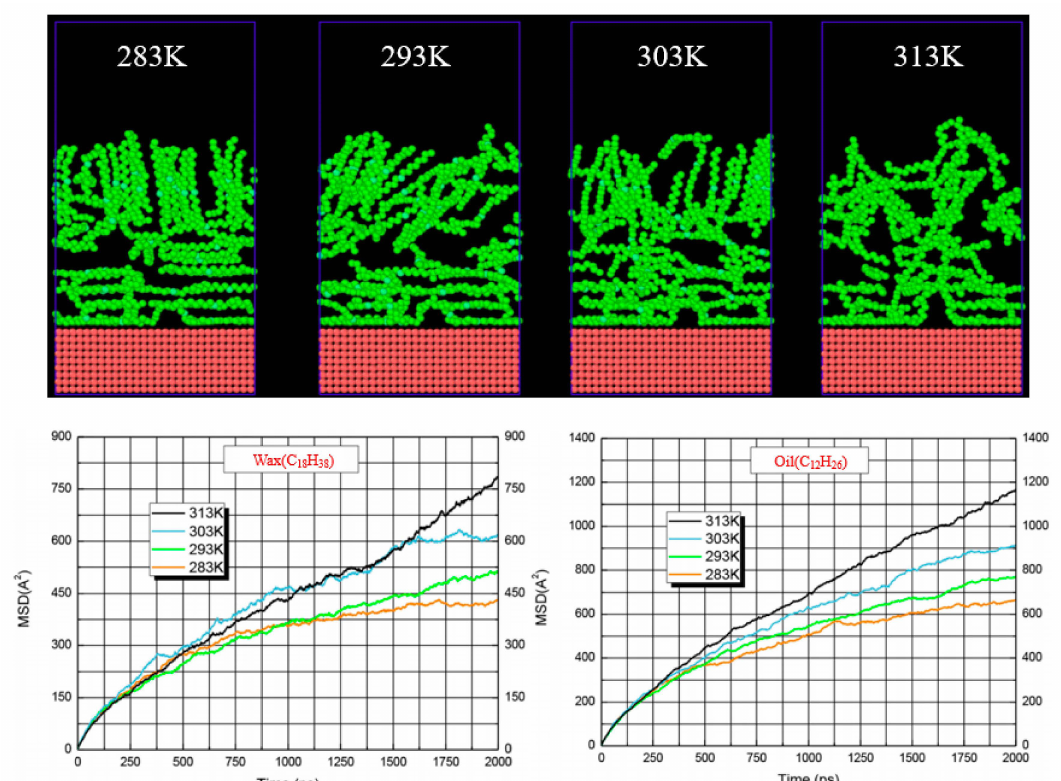
Figure 13. Schematic diagram of molecular dynamics characterization of wax deposition behav- ior